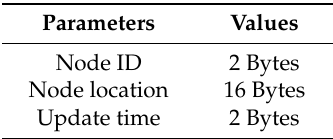
Table 4. Local network location